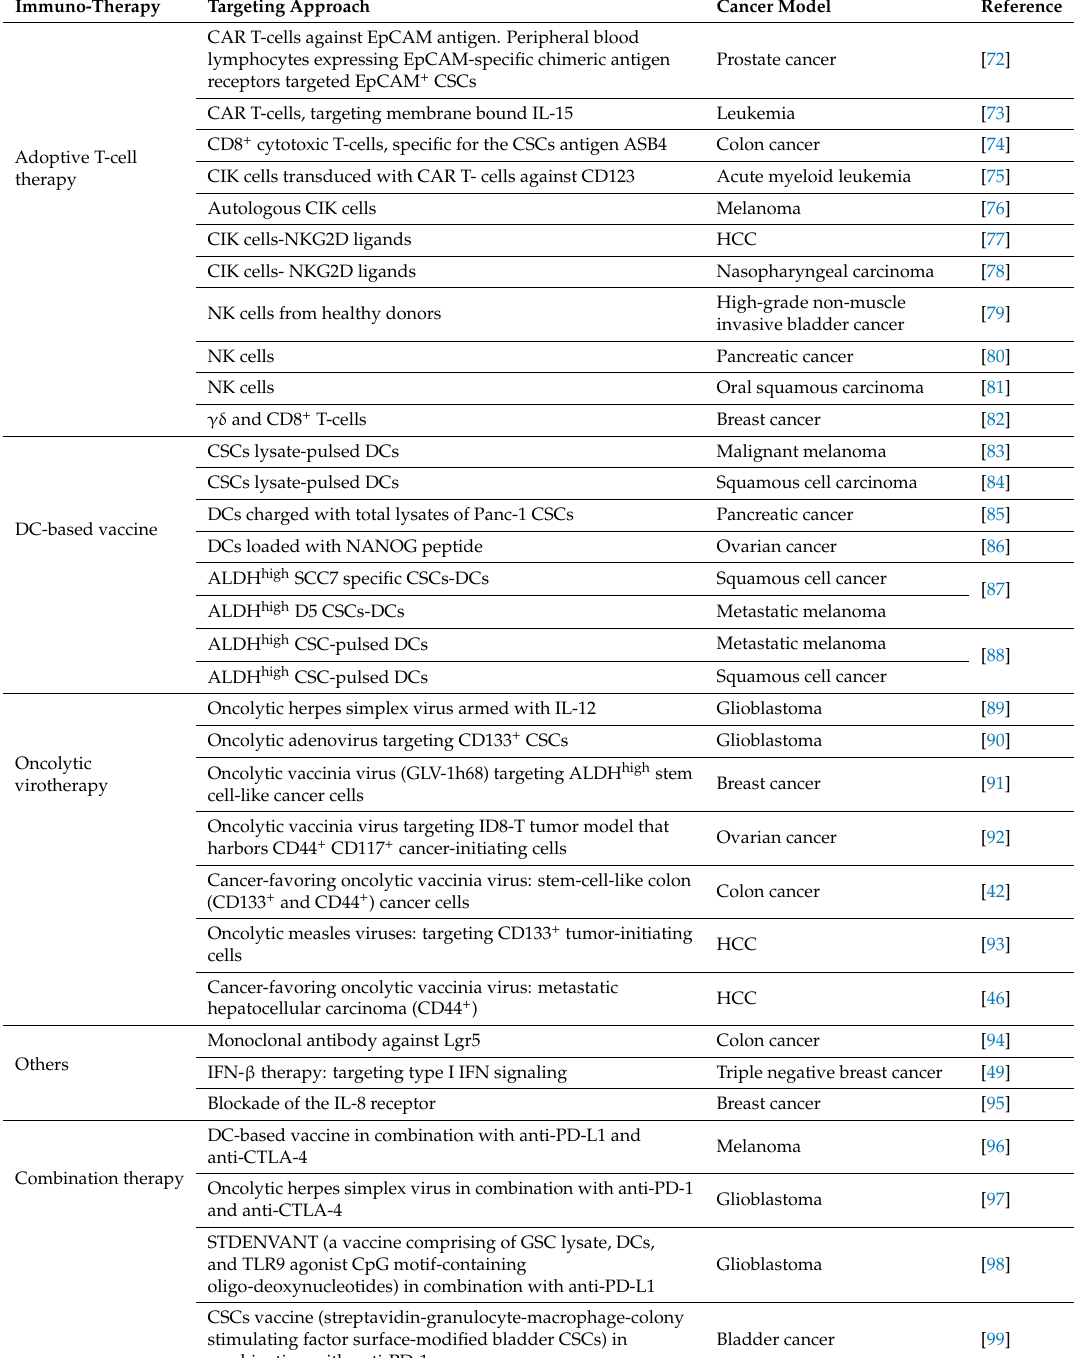
Table 3. Recent advances in targeting CSCs by